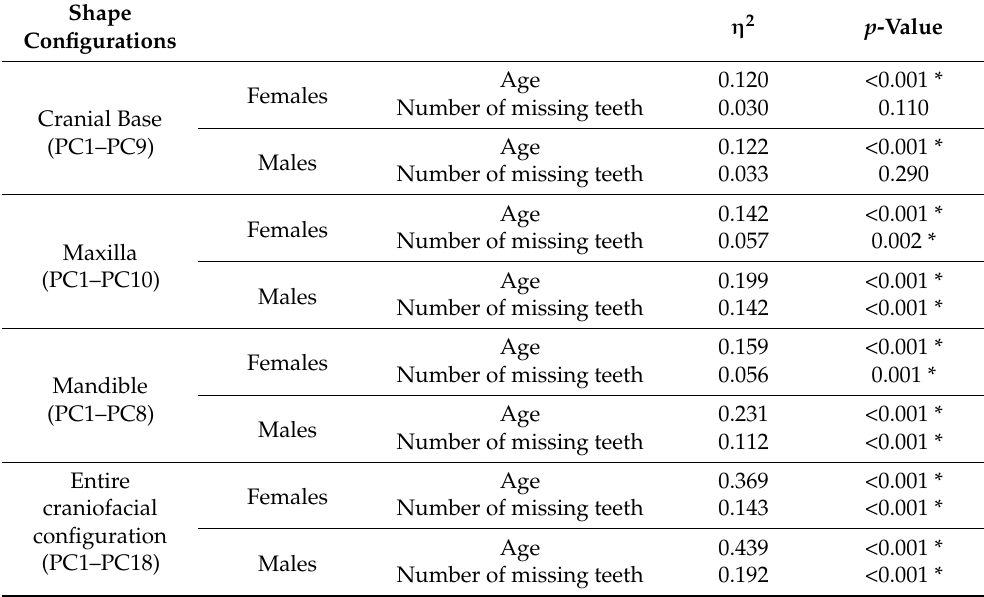
Table 2. Multivariate regression of shape on age and number of missing teeth, without considering third molars, in female ( n = 476) and male ( n = 332) samples. Each shape configuration was described with the number of PCs explaining more than 85% of shape variation, as assessed with the broken- stick method.